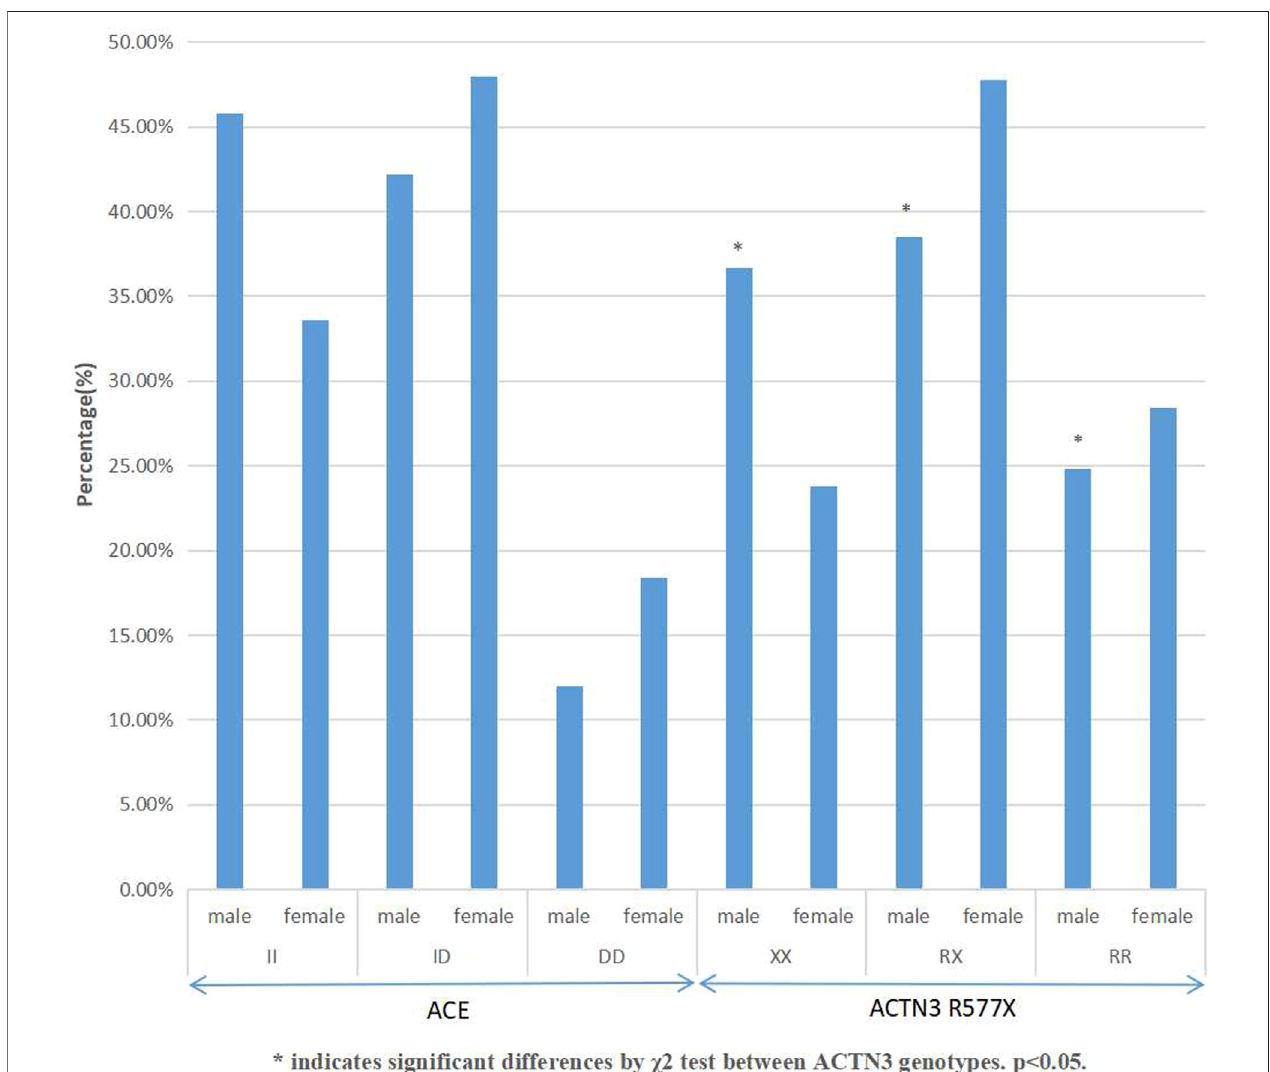
FIGURE 1 | Distribution of ACE and ACTN3 gene polymorphisms in elite Chinese